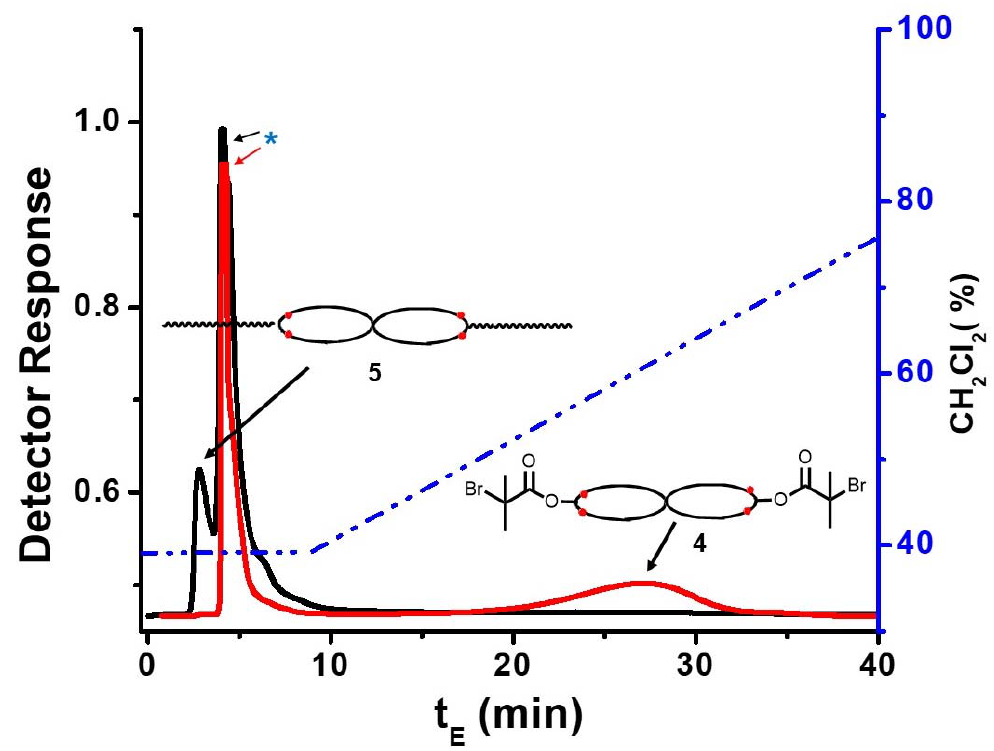
Figure 7. Solvent gradient reverse-phase HPLC fractionation of the spirocyclic macroinitiator and triblock copolymer recorded using a UV detector at 260 nm: spirocyclic macroinitiator (red line), PMMA- b -cPS- b -PMMA triblock copolymer (black line), and * indicating solvent peak.